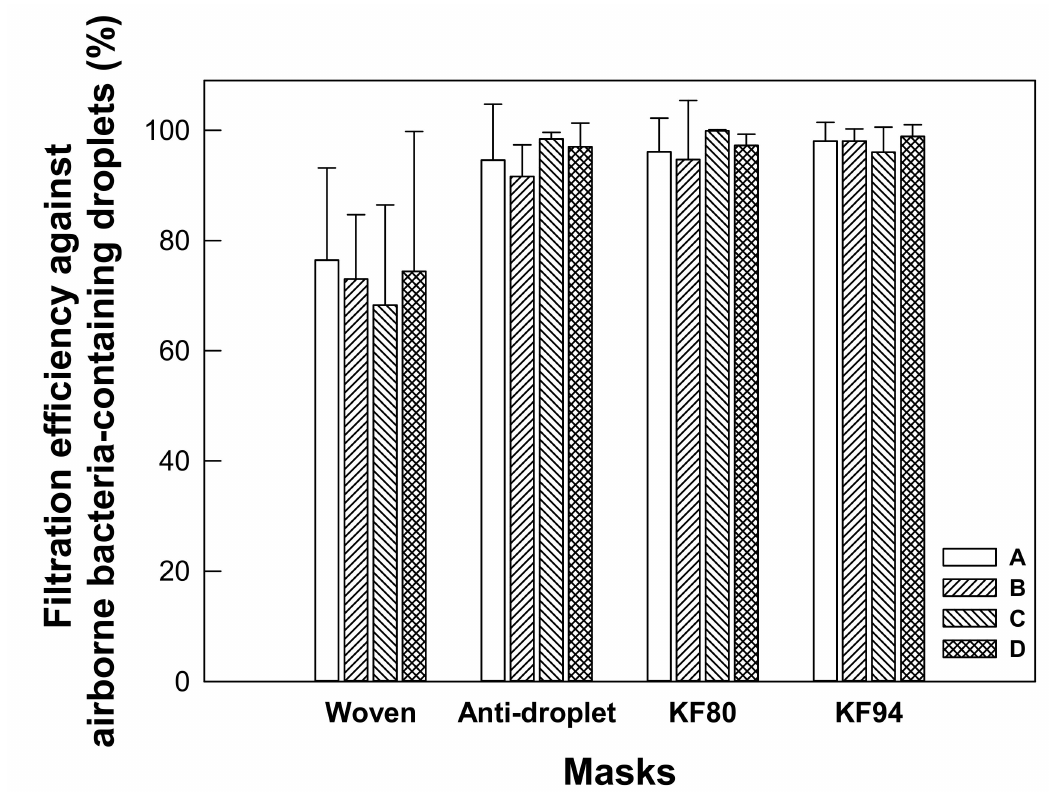
Figure 3. Filtration performances of commercially available face masks against airborne bacteria-containing droplets ( n = 3). A, B, C, and D indicate categories of the masks described in Table